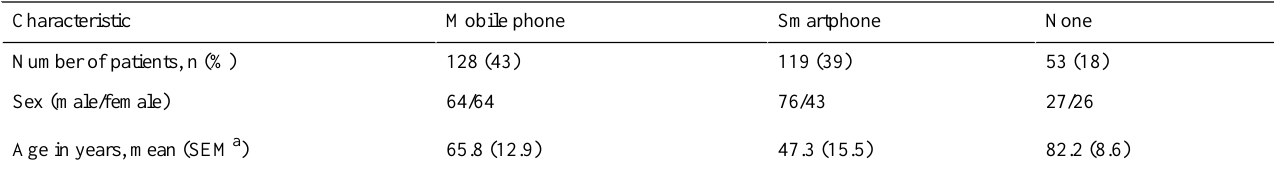
Table 1. Patient characteristics of mobile phone usage.